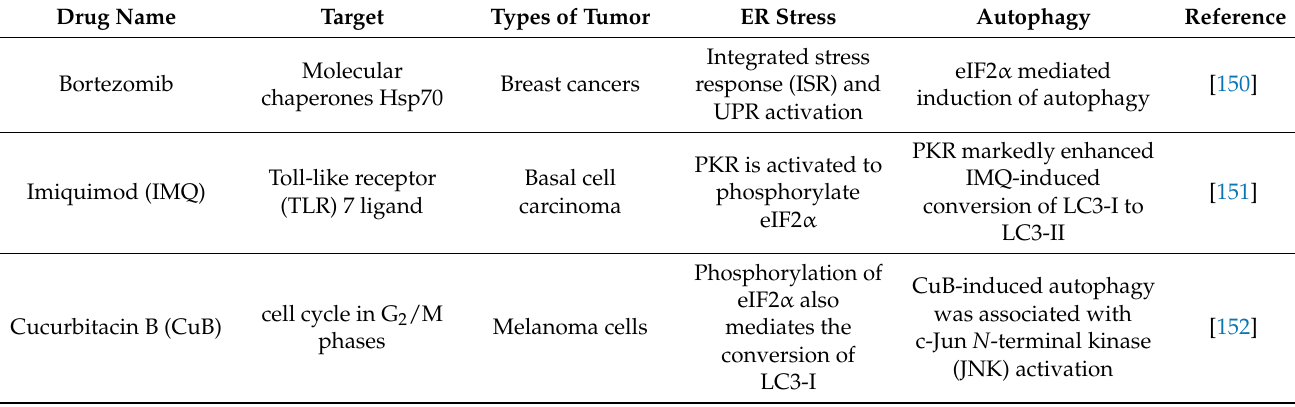
Table 2. FDA approved anticancer drugs that modulates ER stress-mediated